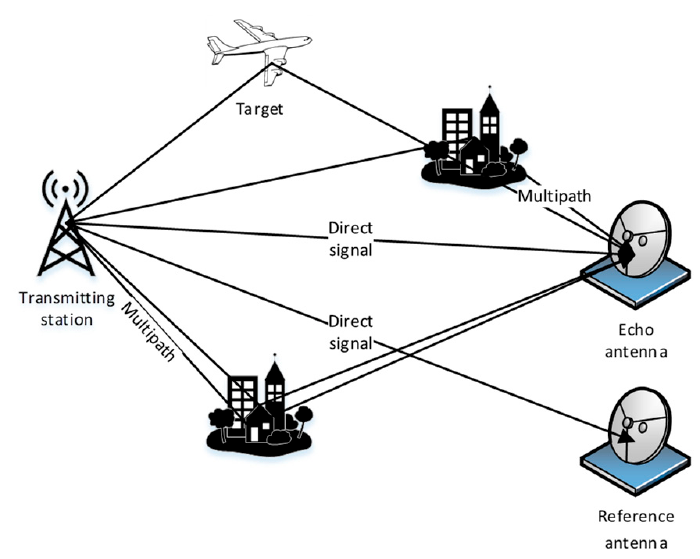
Figure 1. Passive radar system schematic.